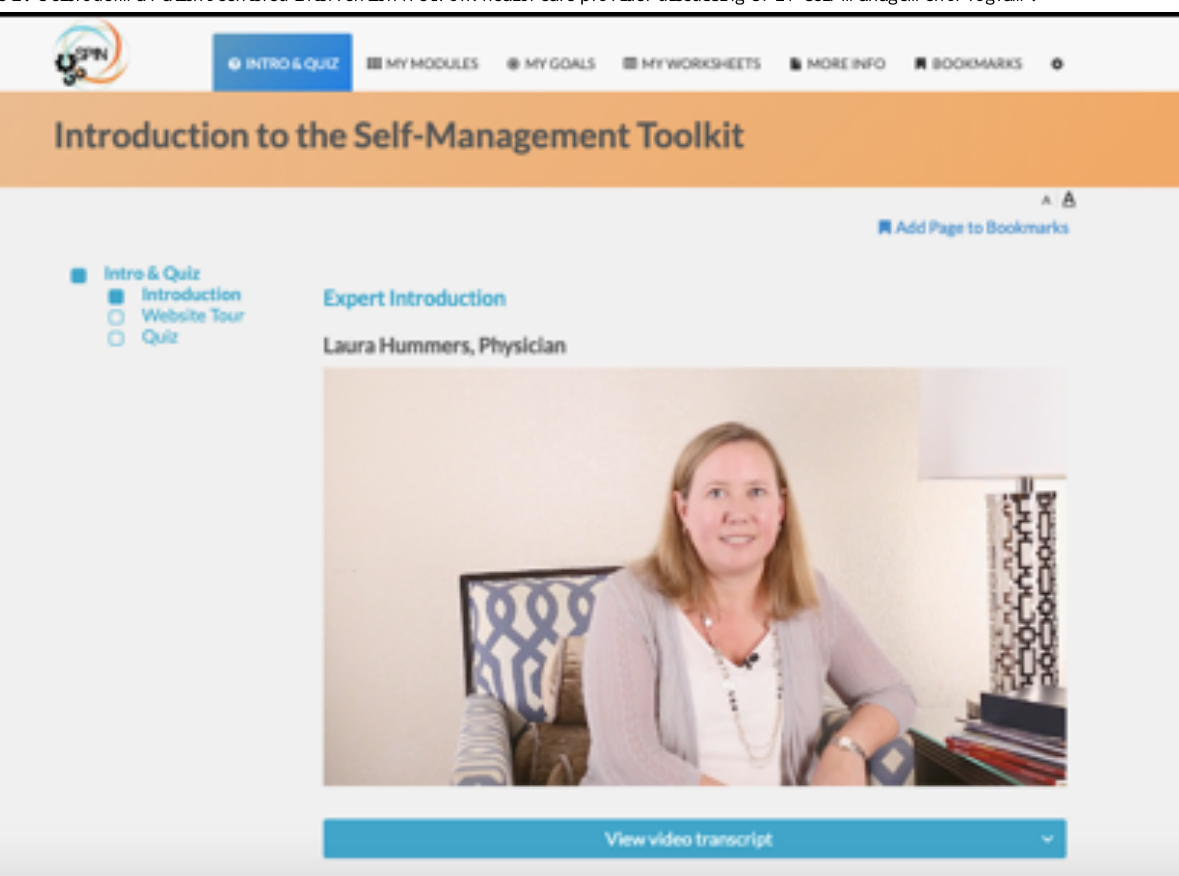
Figure 2. Scleroderma Patient-centered Intervention Network health care provider discussing SPIN-self-management